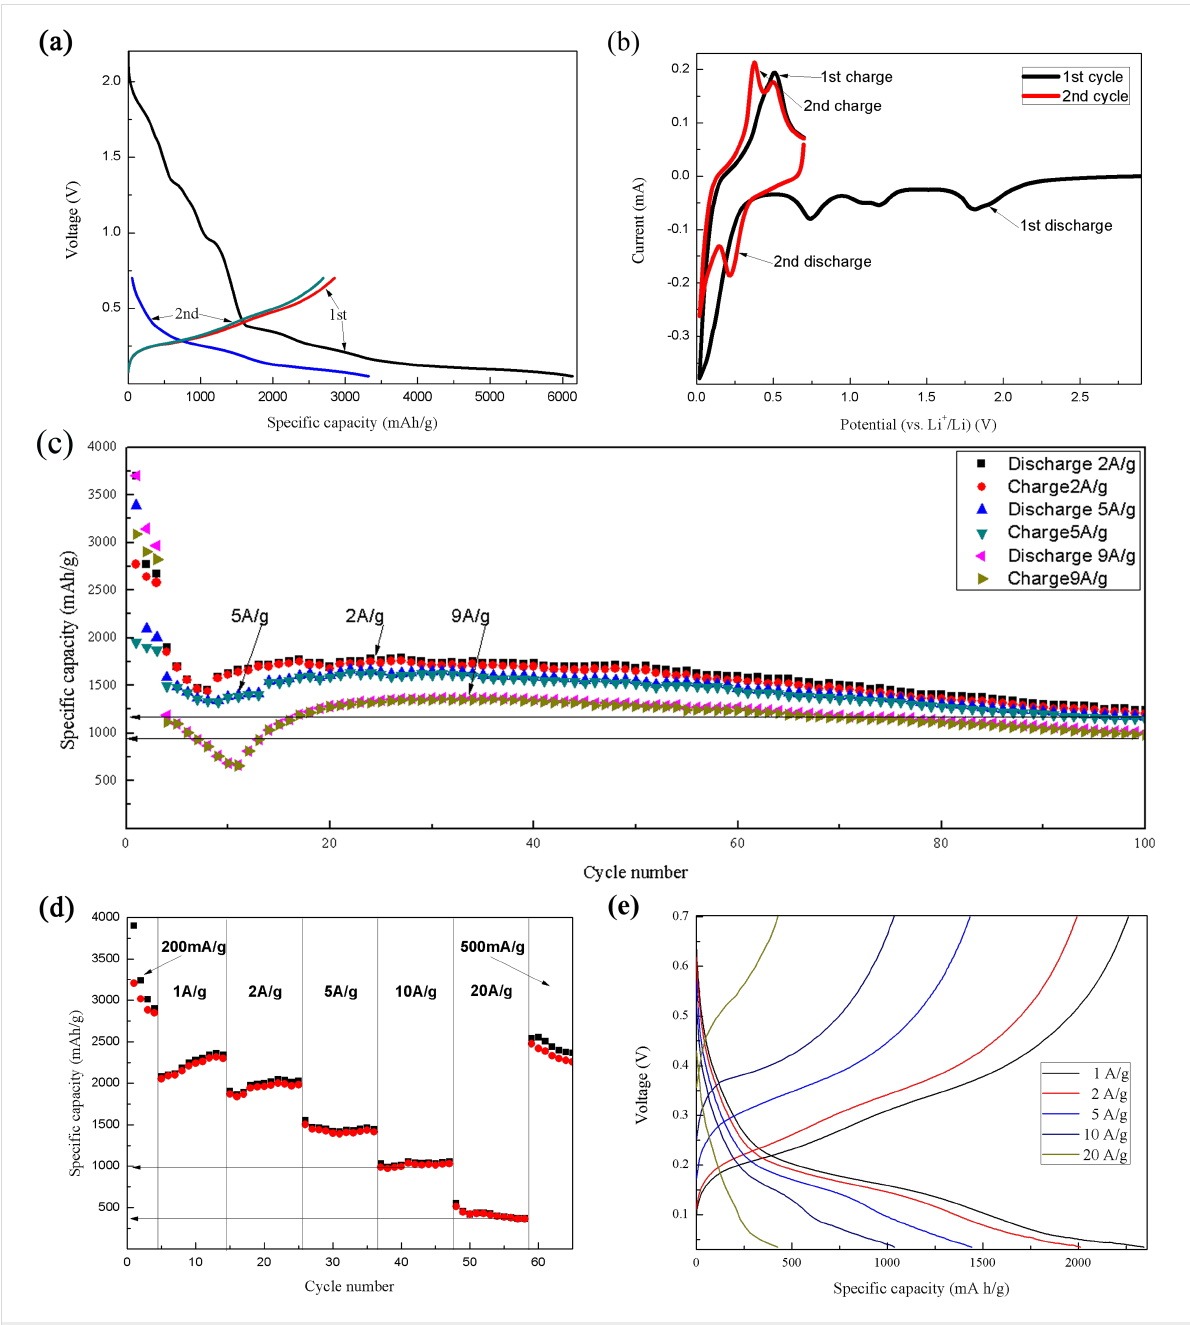
Figure 4: Electrochemical performance of the Si anode. (a,b) Galvanostatic discharge–charge profiles and CV curves for the initial two cycles. (c) Cycling at 2 A/g, 5 A/g and 9 A/g, (d) rate performance, and (e) galvanostatic discharge–charge profiles of Figure 4d.